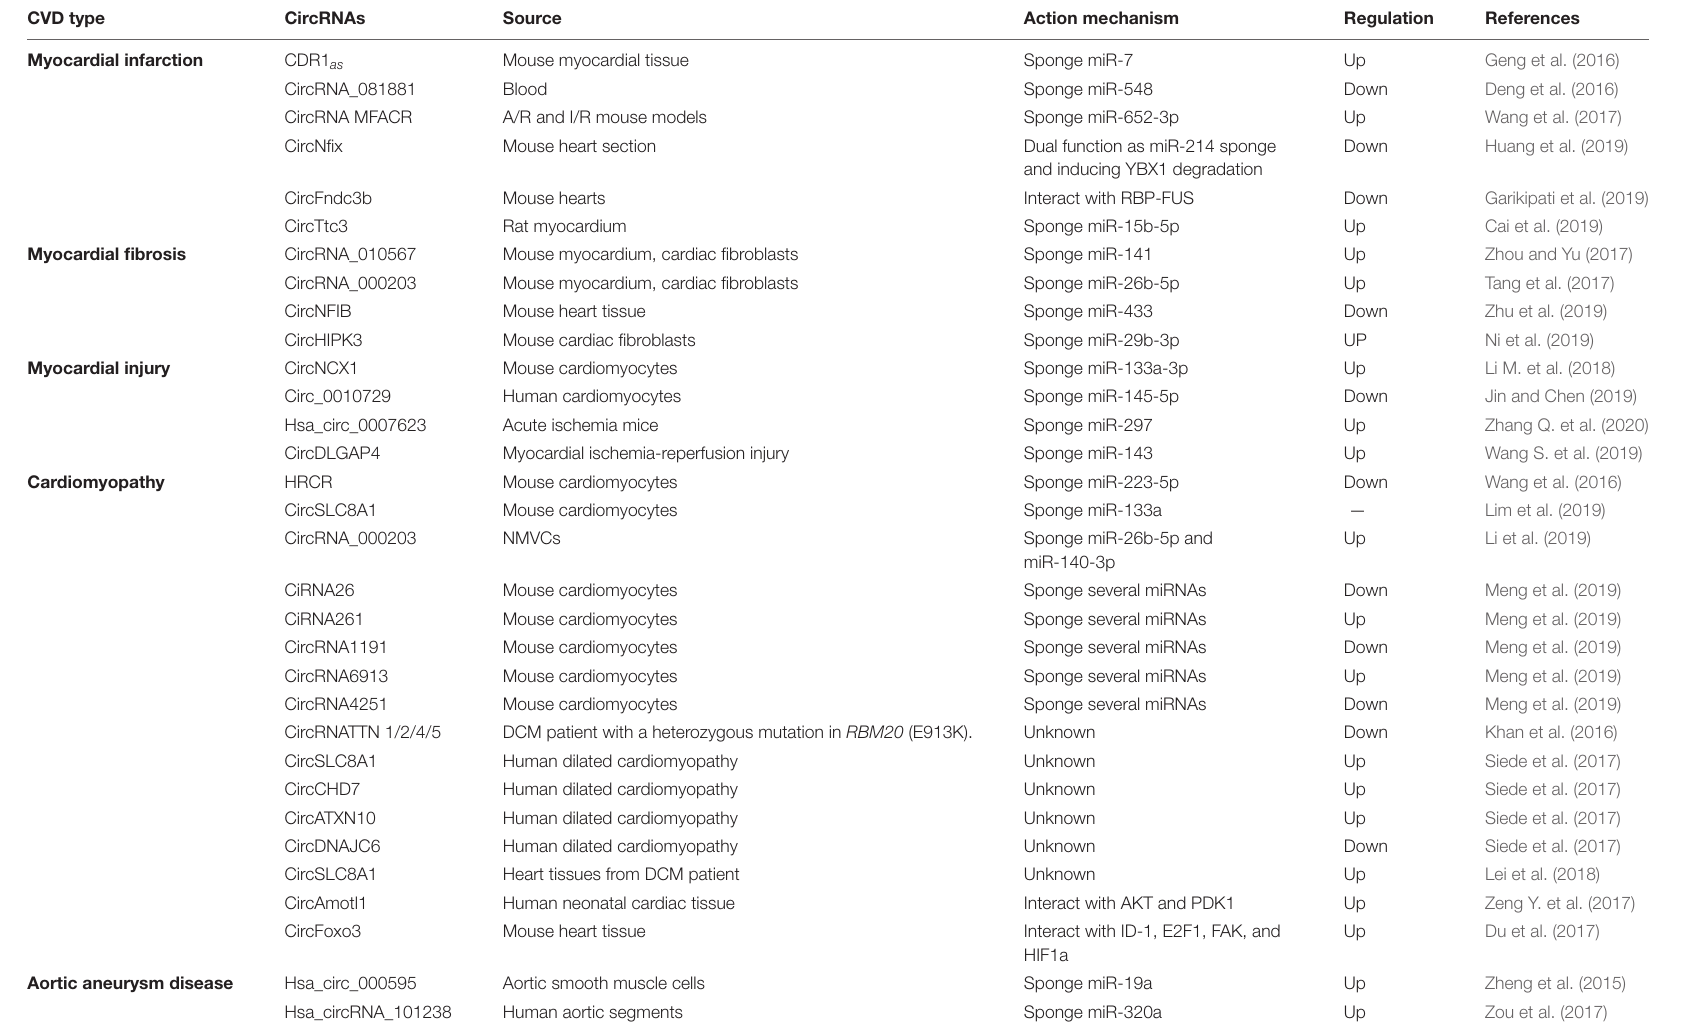
TABLE 2 | CircRNAs with